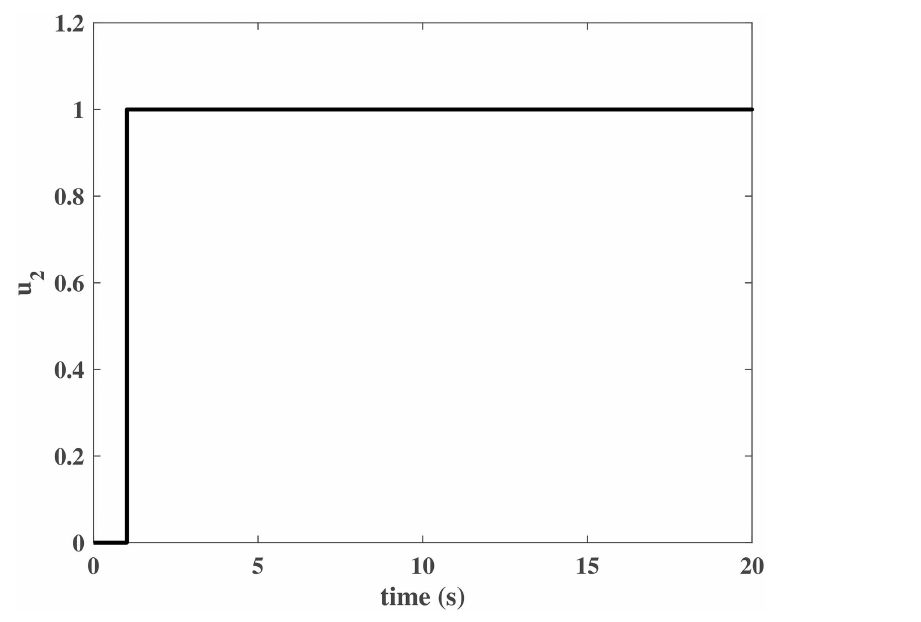
Fig 9. Controller output u 2 in the numerical simulation.